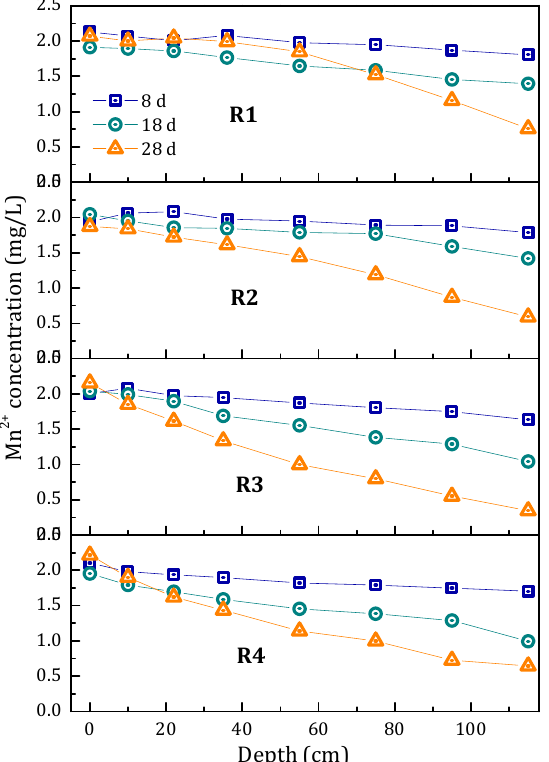
Figure 3. The effect of influent Fe 2+ concentration on the variation of Mn 2+ concentration along the depth of the filters at different running time.